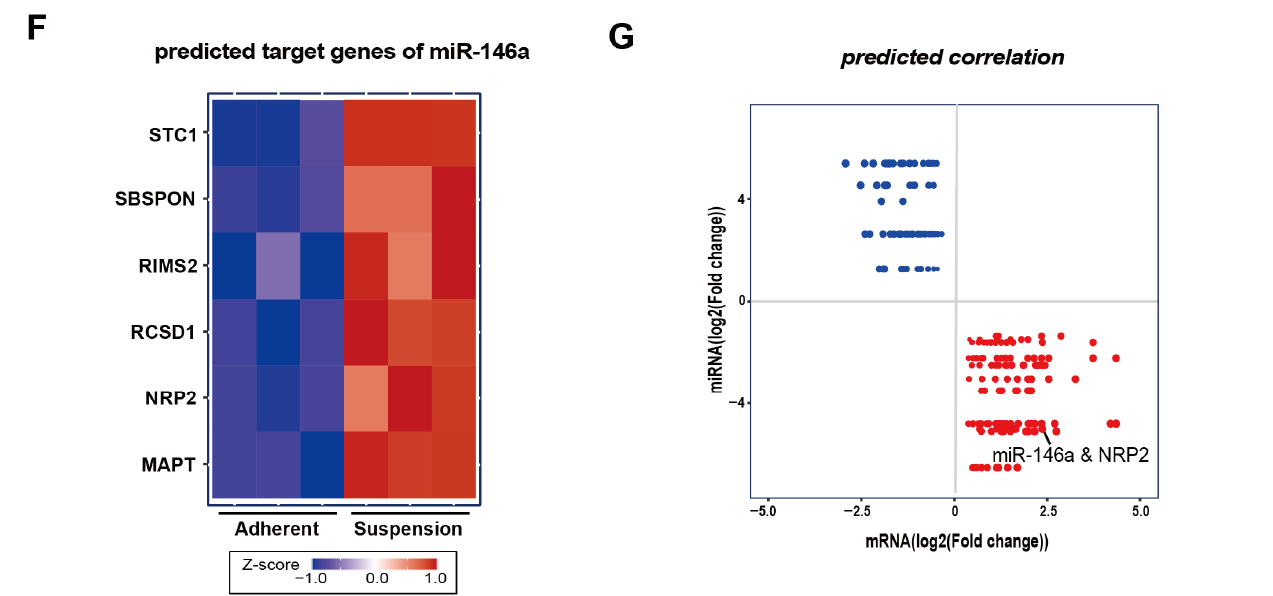
Figure 1. Integrative analyses of mRNA-miRNA sequencing showing differentially expressed miRNAs and the predicted targets of miR-146a. ( A ) Scatter plot showing 89 differentially expressed miRNAs (obtained through small-RNA sequencing) in MDA-MB-468 suspension cells compared to adherent cells. The threshold for differential miRNA expression (|FC| ≥ 1.2) and adjusted p -value (<0.05) is indicated on log2 and log10 scales. ( B ) Relative expressions of significantly downregulated miRNAs in adherent and suspension cells. ( C ) Scatter plot indicating 601 DEGs (obtained through mRNA sequencing) in suspension cells compared to adherent cells. The threshold for differential miRNA expression (|FC| ≥ 2) and adjusted p -value (<0.05) is indicated on log2 and log10 scales. ( D ) RNA-seq-based gene ontology analysis of 209 upregulated genes. ( E ) GO analysis of upregulated genes involved in semaphorin–plexin signaling pathway. ( F ) Heatmap of predicted miR-146a targets between adherent cells and suspension cells. ( G ) Scatter plot of fold changes for predicted correlation between mRNA and miRNA (Blue: high miRNA and low mRNA, Red: low miRNA and high mRNA).